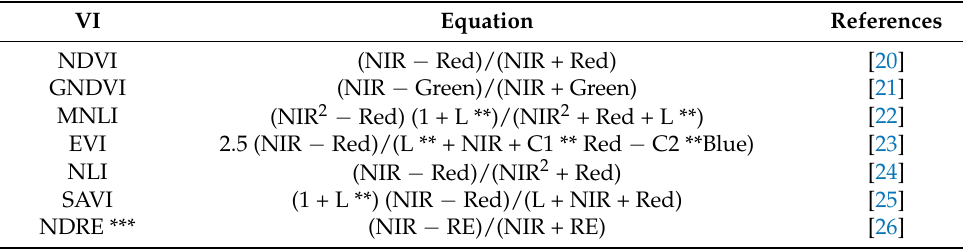
NDVI: Normalized Difference Vegetation Index; GNDVI: Green Normalized Difference Vegetation Index; MNLI: Modified Non-Linear Index; EVI: Enhanced Vegetation Index; NLI: Non-Linear Index; SAVI: Adjusted Vegetation Index; NDRE: Normalized Difference Red Edge Index; ** L = 0.5; C1 = 6; C2 = 7.5. *** VI not used for the satellite because the sensor does not provide the RedEdge